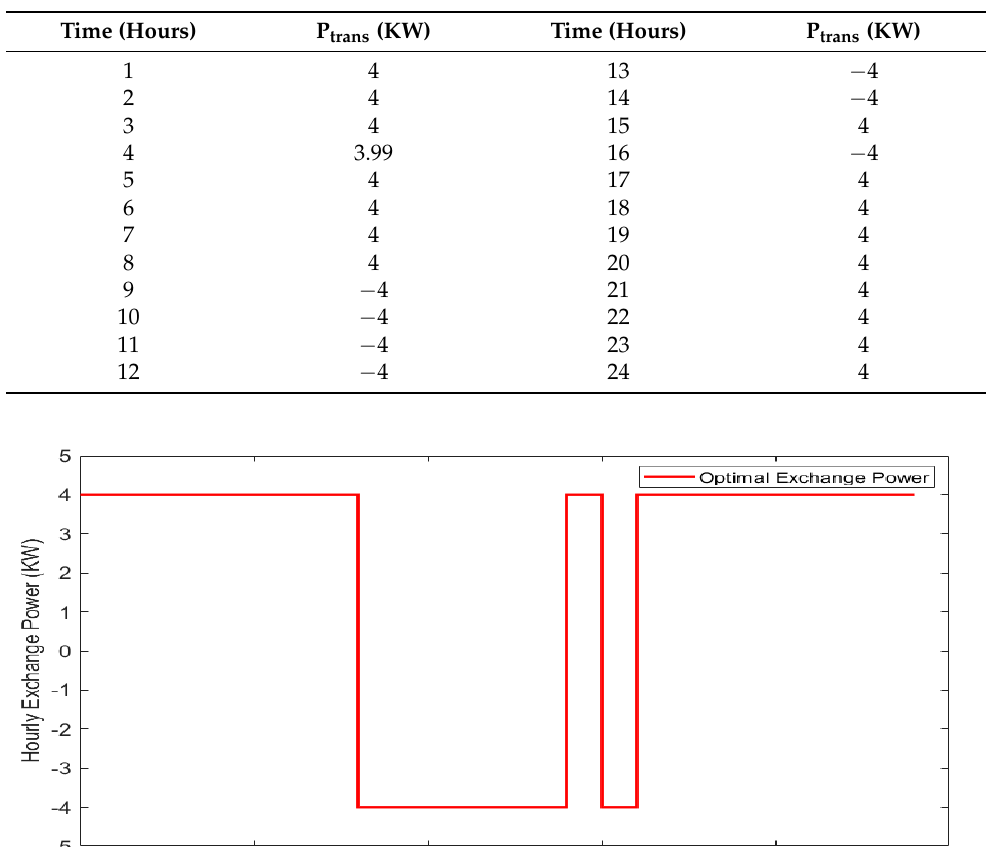
Table 8. Exchange power between main grid and microgrid.